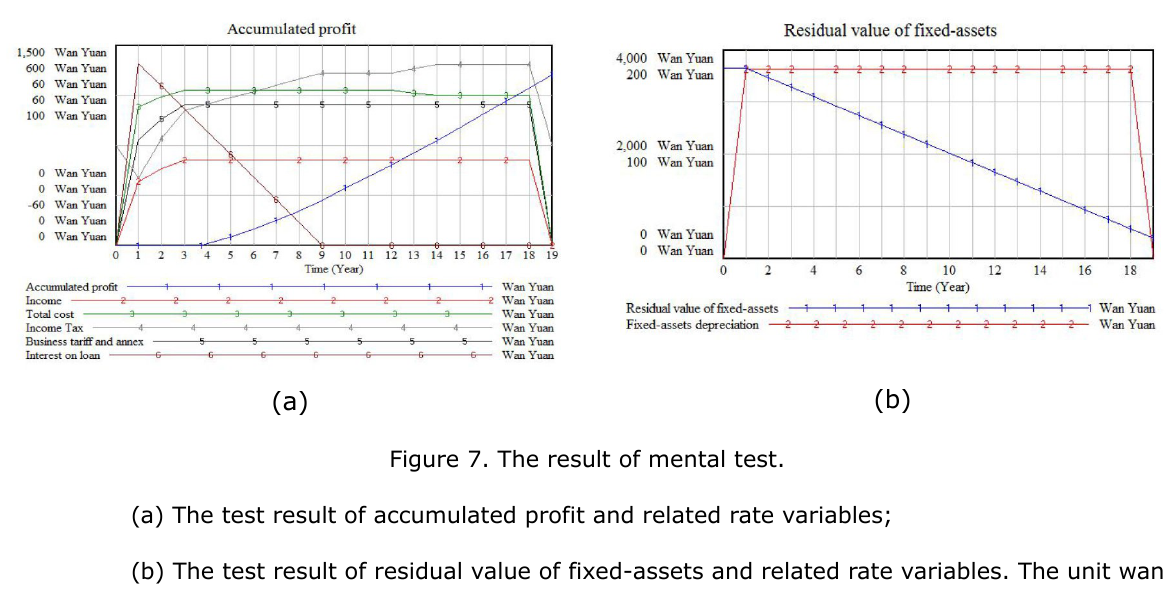
Figure 7. The result of mental